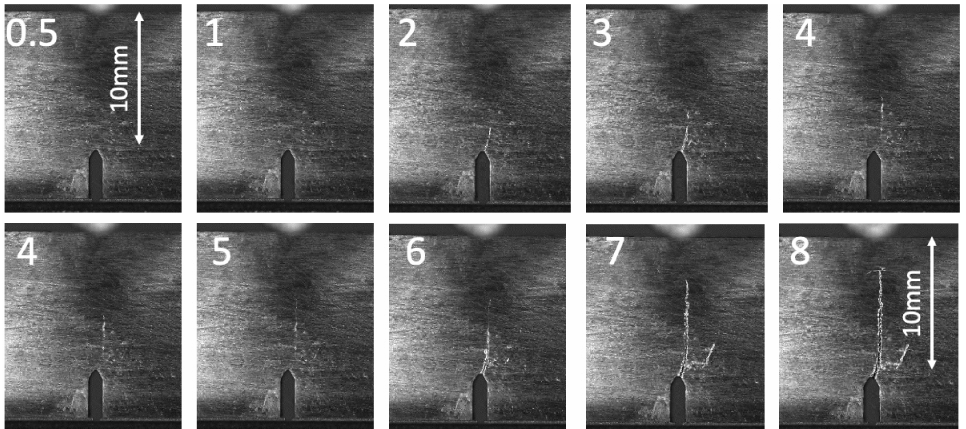
Figure 10. Crack propagation during a 3-point bending test of a large sample, with numbers indicating the crack opening measured from the pre-notch.